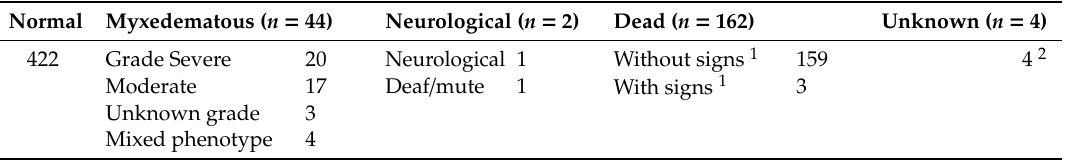
Table 1. Phenotype classification of the subjects with endemic congenital hypothyroidism (CH)